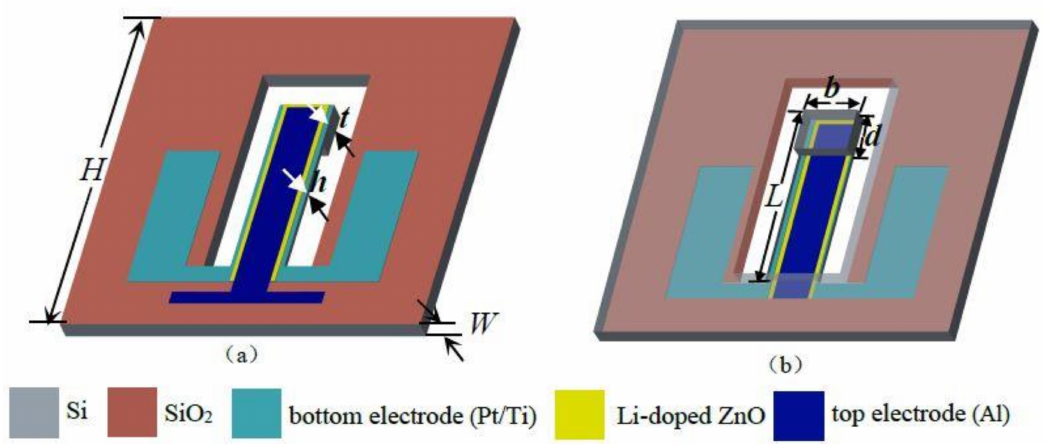
Figure 1. Basic structure of the acceleration sensor: ( a ) front view; ( b ) back